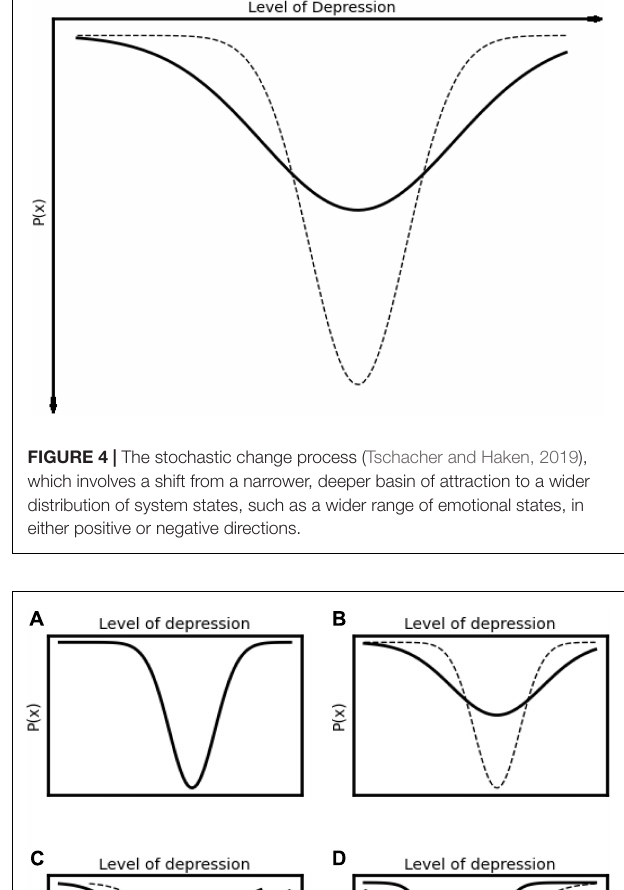
(indicated in Figure 5 ): first, the chaotic elements of change widen the basin of attraction of the system states, then deterministic elements of change move the basin toward a (hopefully) more desired direction, before it deepens again to become a new stable point of the system (through the self- organization processes of the system, or changes in contextual factors). In the example above, it may mean a depressed person starting to have a wider range of emotions, before starting to have a reduced level of depression, and this then becoming a new